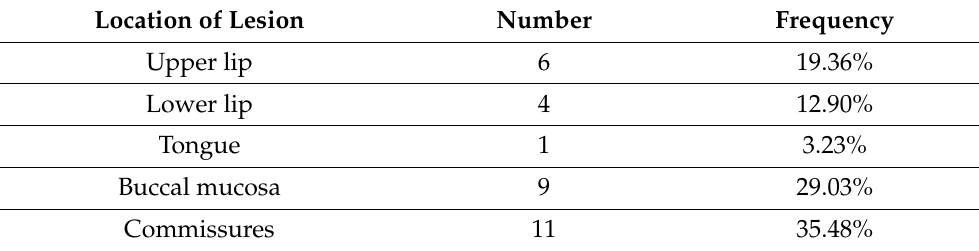
Table 4. Frequency of oral self-inflicted lesions according to